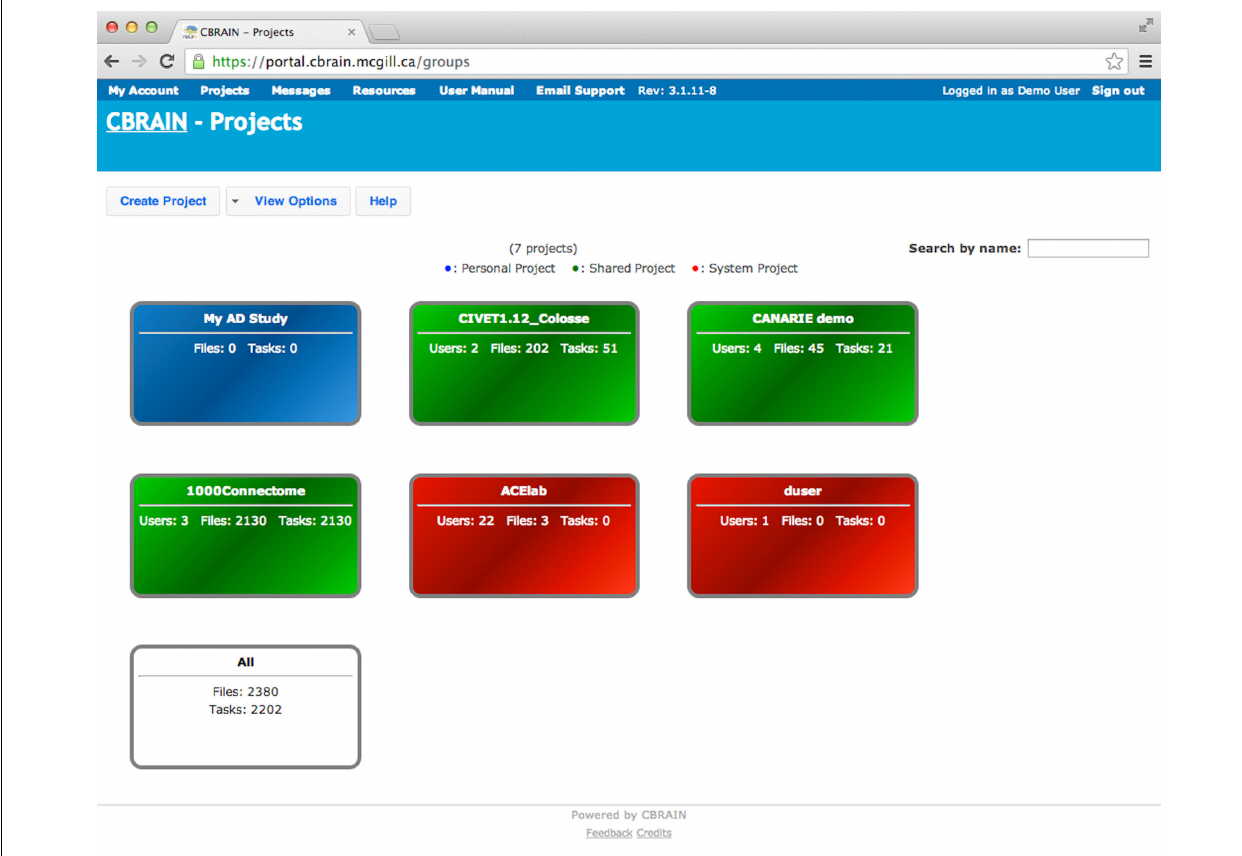
API allows decoupled cross-platform interoperability; any autho-